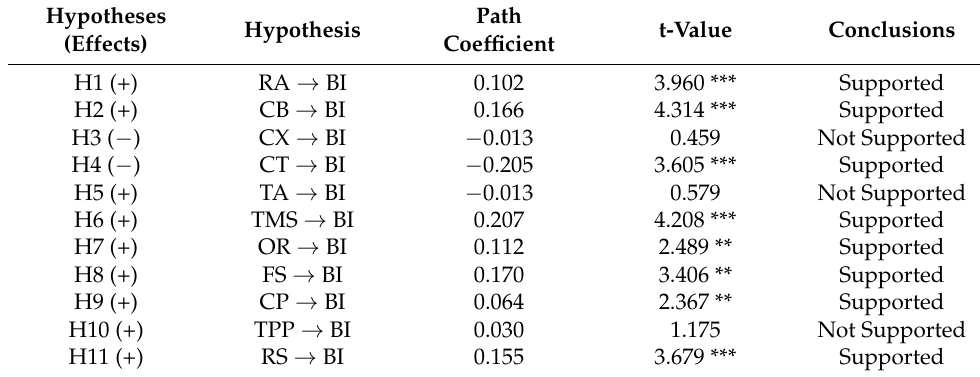
Figure 3. Measurement model. Table 3. Path analysis